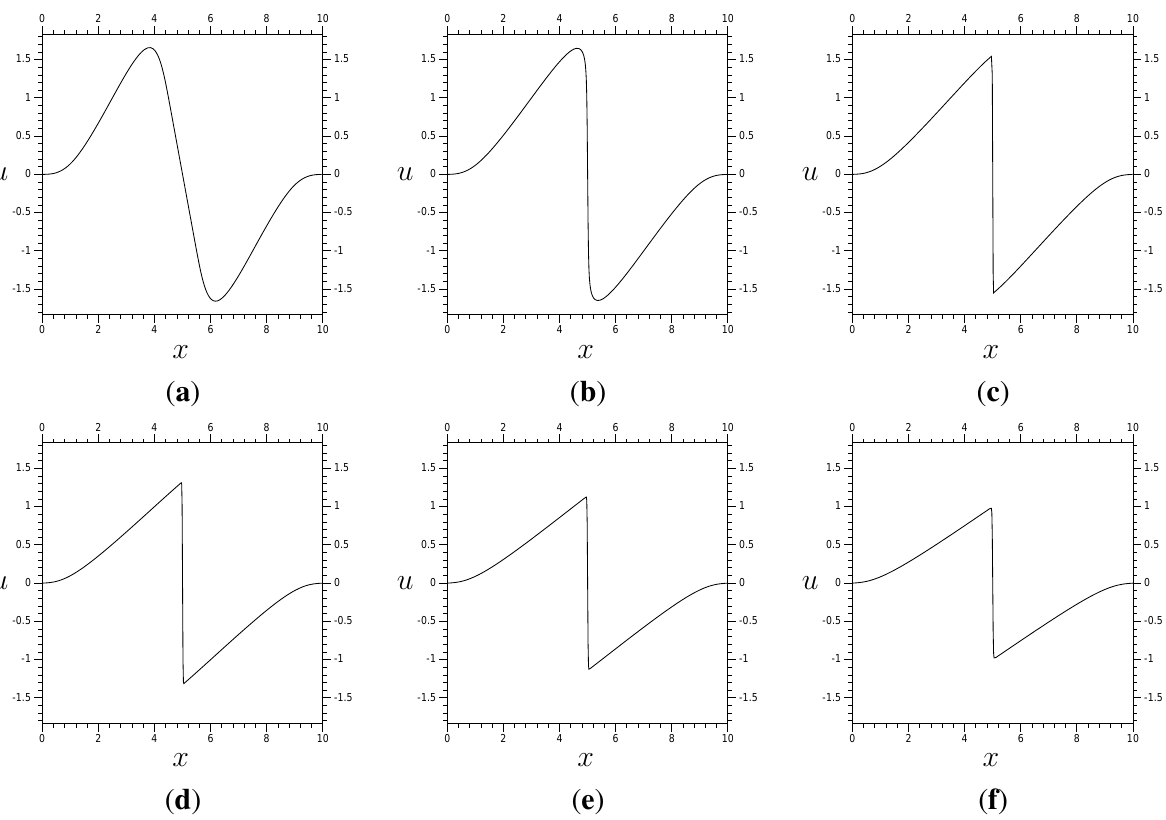
Figure 6. Results for Burgers’ equation using the components from Section 8. These use V − with localized V − and three “extra” coefficients a − 4 6 ) uses ( J values of 0, 0, 0, 0, 1 , 1, 1, etc. The time step size is h = 0 . 01 . ( a ) t = 0 . 5 ; NL i;i 2 ( b ) t = 1 . 0 ; ( c ) t = 1 . 5 ; ( d ) t = 2 . 0 ; ( e ) t = 2 . 5 ; ( f ) t = 3 . 0